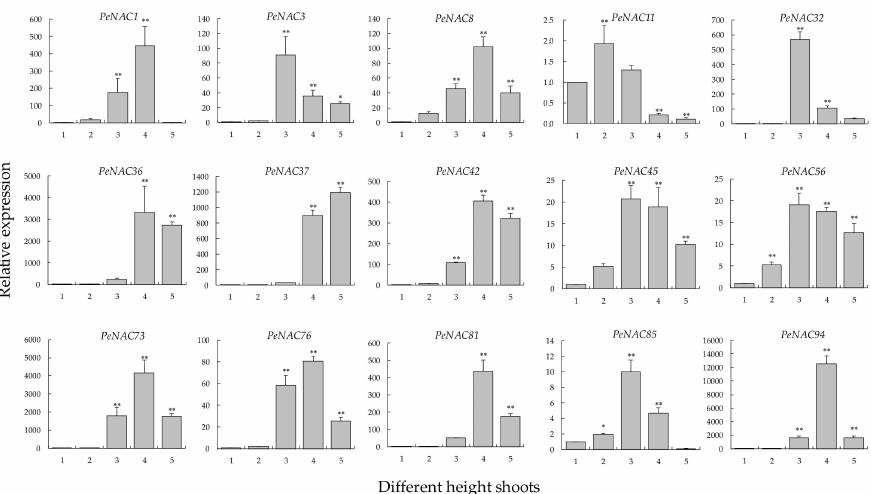
Figure 8. Expression analysis of 15 PeNAC s in di ff erent height shoots using qRT-PCR. PeNTB was used as the reference gene. Average and error bars represented standard deviation of three biological replicates. Asterisks indicated significant di ff erence compared to the transcription level of control groups (* p < 0.05, and ** p < 0.01). 1: 1.0 m shoots; 2: 2.0 m shoots; 3: 4.0 m shoots; 4: 6.0 m shoots; and 5: 8.0 m shoots.